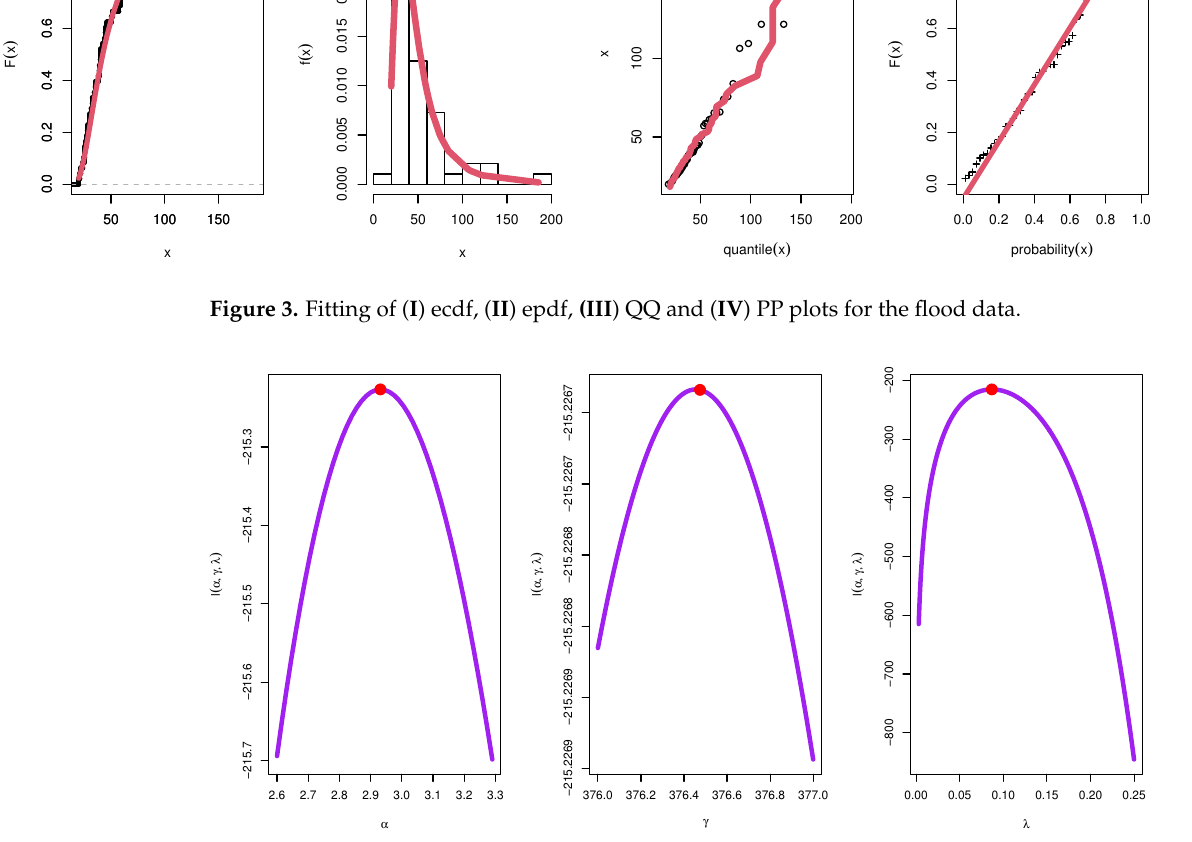
Figure 4. Profile likelihood α , γ , and λ for the flood